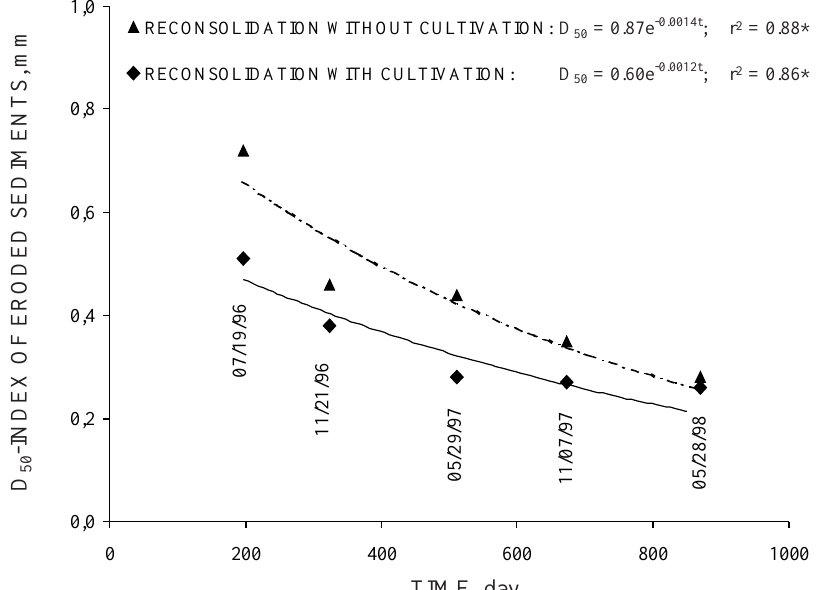
Figure 6. D -index of eroded sediments during constant discharge as a function of time in the 50 reconsolidating soil